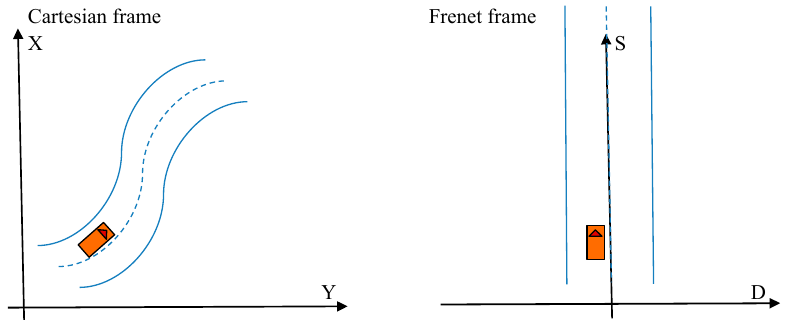
Figure 5. Cartesian frame to Frenet frame transformation.